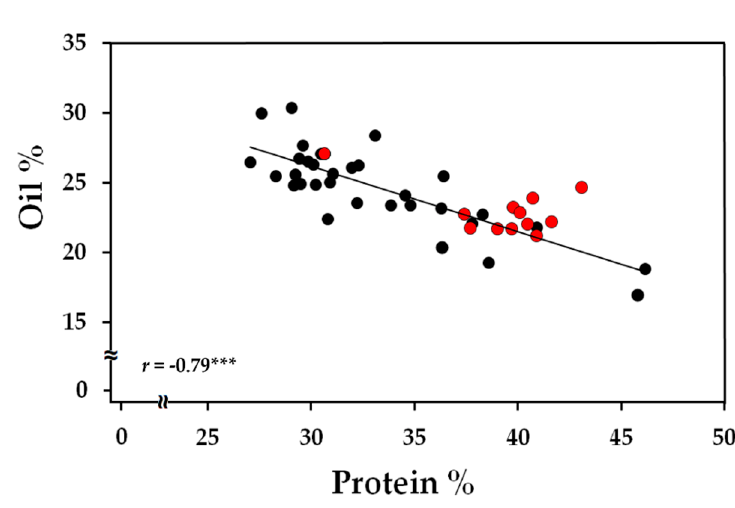
Figure 2. Correlation plot for oil and protein content represented as % biomass at maturity. A total of 11 FN lines with four biological replicates were used in the analysis. Red markers represent the three lines, FN300660, FN300012, and FN301952, from the Williams 82 mutagenized population. r represents the Pearson’s correlation coefficient and *** indicates a significance of p < 0.001.